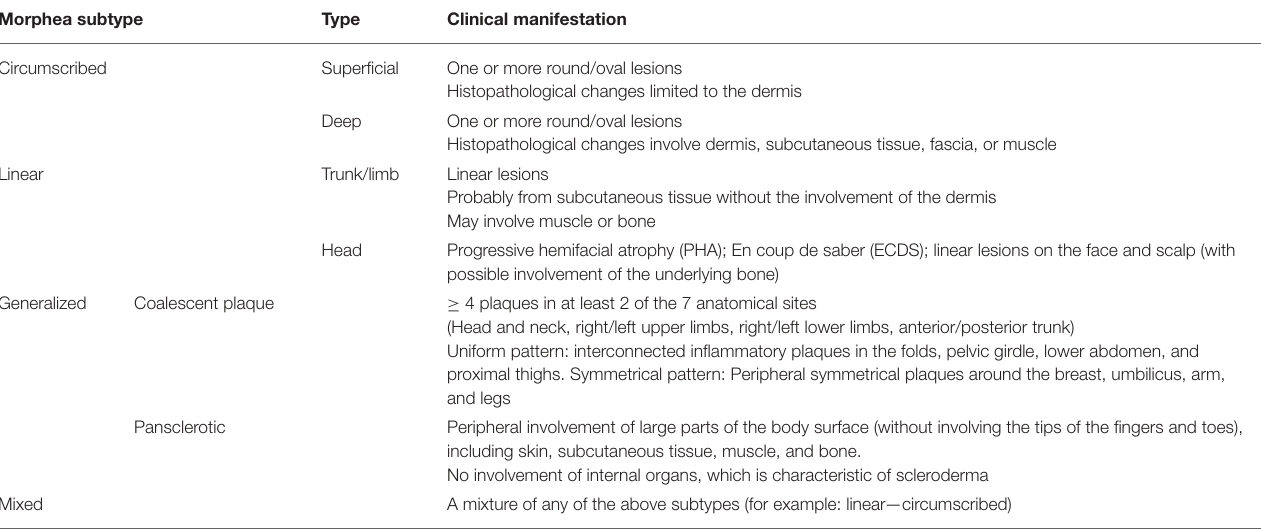
TABLE 1 | Categories of different types of morphea.